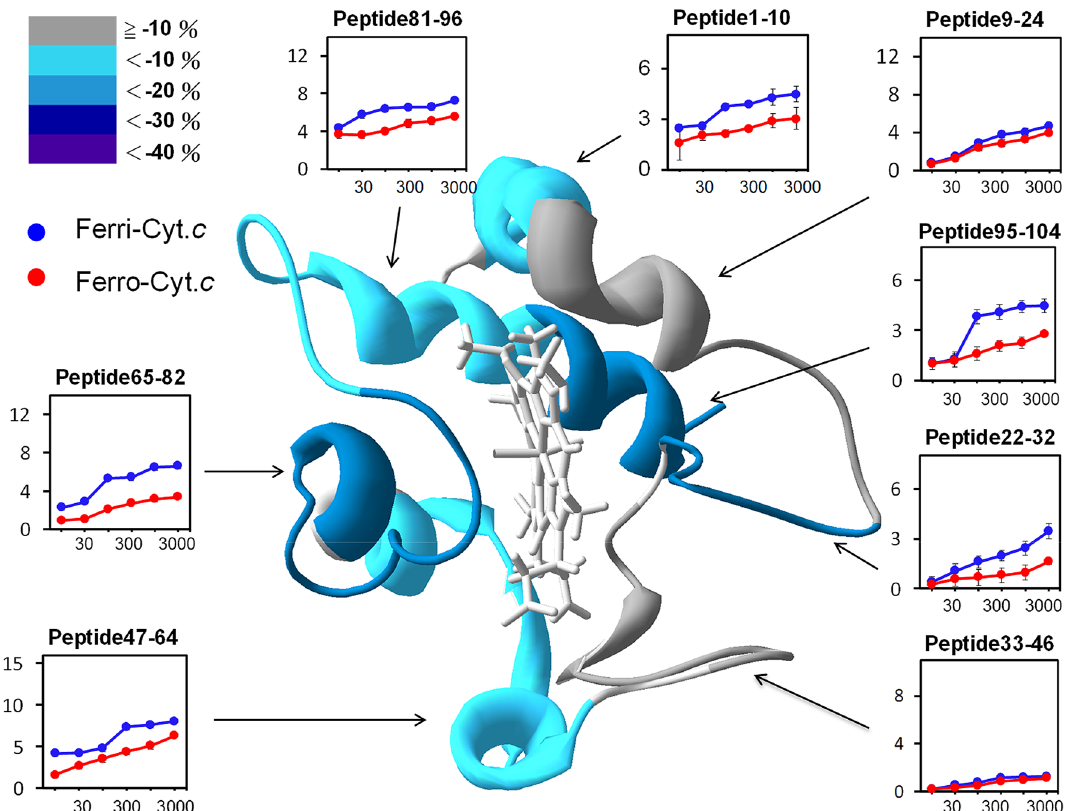
Figure 4. Deuteration level of ferric (blue) and ferrous (red) cyt c represented by peptide fragments. The difference in the deuteration level between ferric and ferrous cyt c is illustrated in percentage [(ferrous − ferric)/ ferric × 100%] in different colors (scale shown in the top-left corner). The time-course deuterium number of each fragment related to the corresponding region of cyt c (the ribbon diagram shown in the center of the figure) was